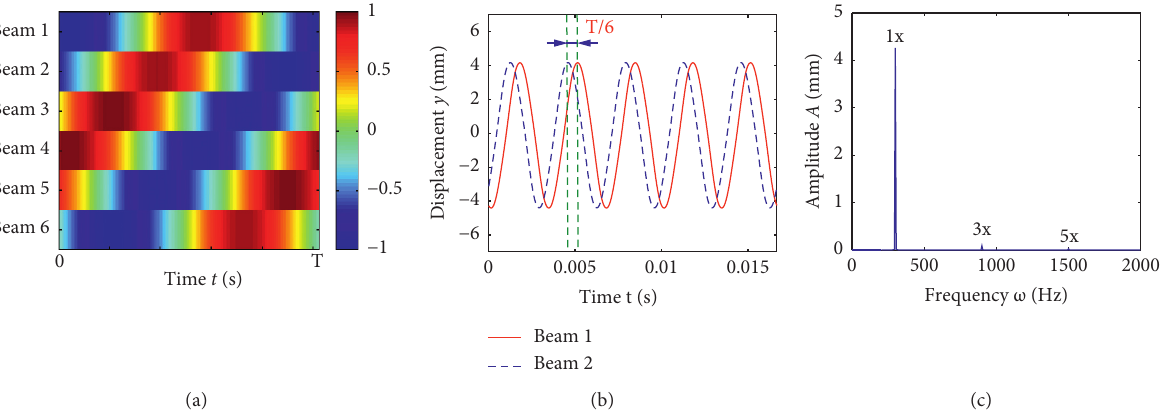
Figure 15: The response of beam tip with respect to case 2 ( Ω � 200rad/s, F � 300N, ω � 300 Hz): (a) response of beam 1 to beam 6, (b) response curve of beams 1 and 2, and (c) spectrum plot of beam 1.